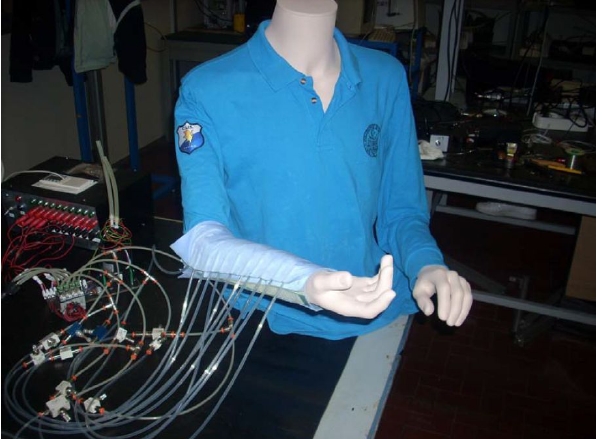
Figure 8. Prototype inflatable compression